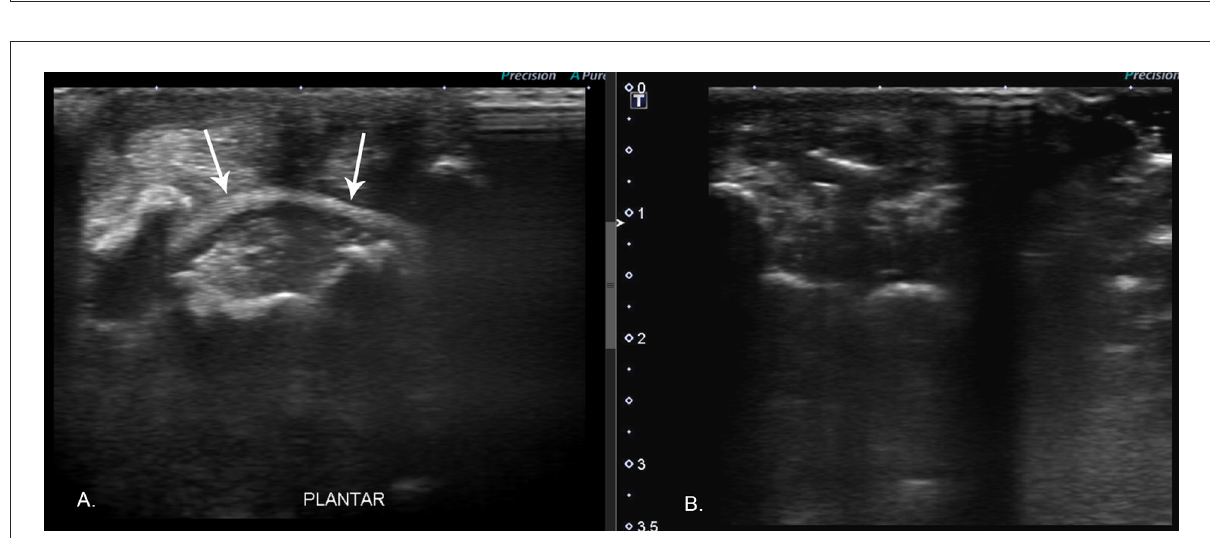
FIGURE2 (A) Preoperative ultrasound image showed a horizontally oriented hyperechoic band (arrows) along the plantar aspect of the limb deep to the flexor tendons and superficial to the metatarsal bones. (B) Intraoperative ultrasound along the same imaging plane demonstrates the absence of foreign